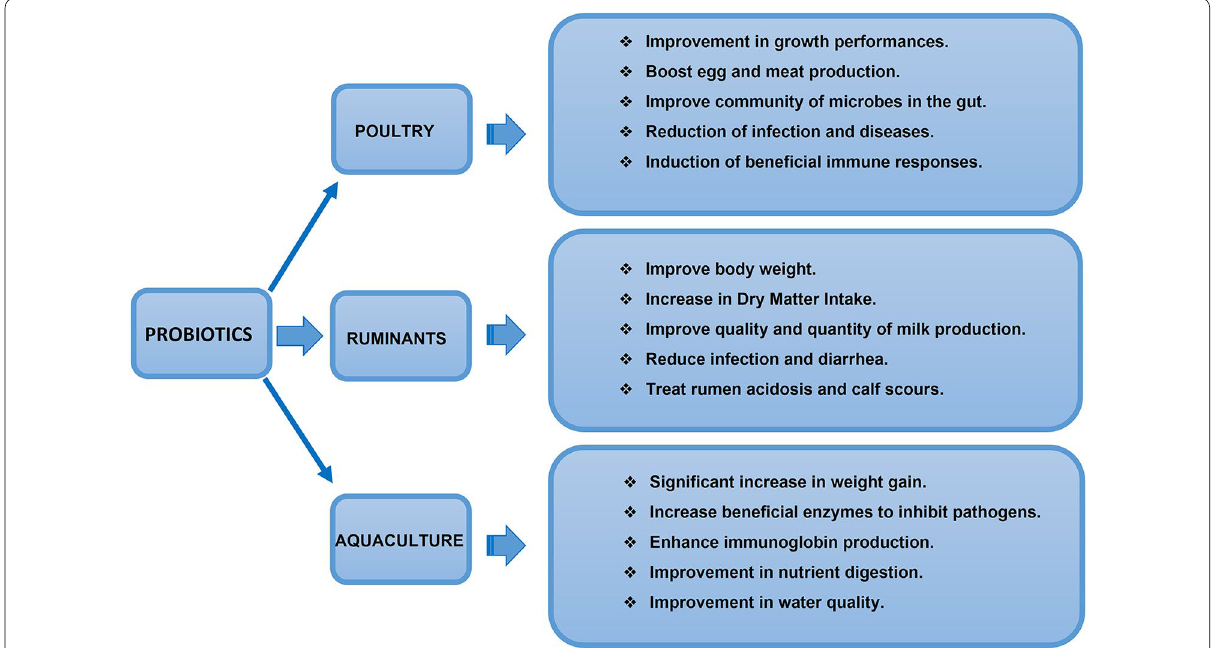
Fig. 2 A flowchart containing an informative summary of beneficial effects of probiotics in animals (poultry, ruminants, and